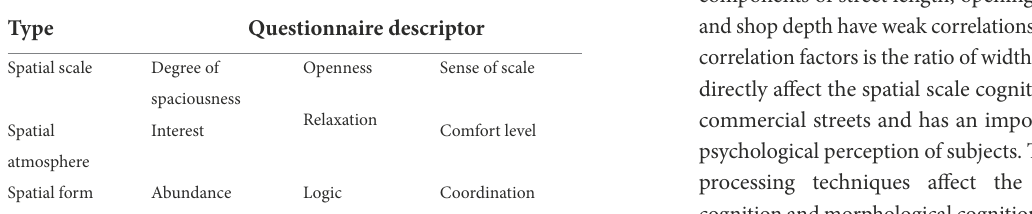
TABLE 1 Description of the